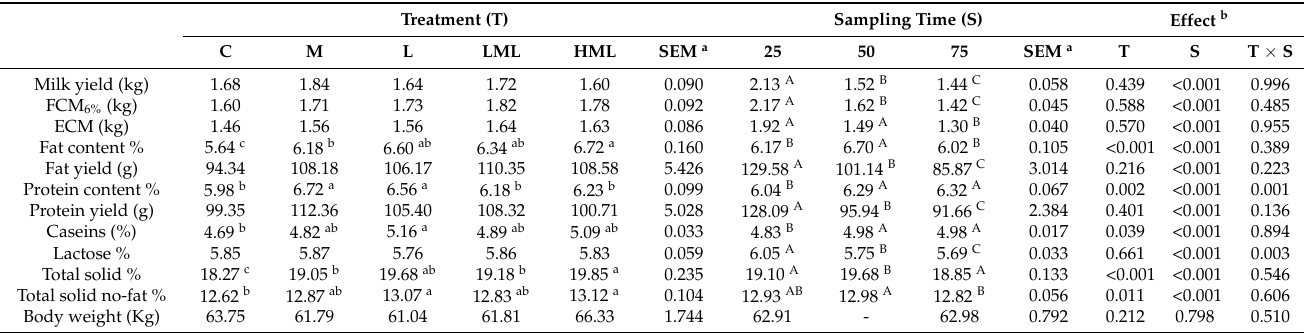
Table 2. Milk performance, chemical composition, and milk’ constituents yield in ewes fed rumen-protected methionine and lysine